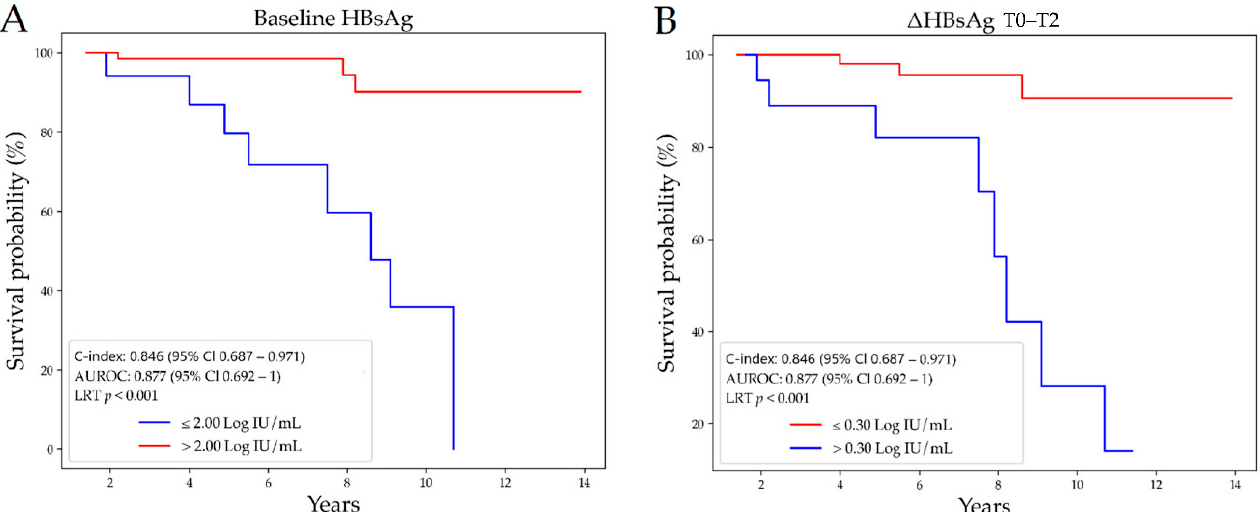
Figure 3. Survival curves for the prediction of HBsAg loss according to baseline HBsAg ≤ 2.00 Log IU/mL ( A ) and Δ HBsAg T0–T2 > 0.30 Log IU/mL ( B ). Survival curve analysis was performed according to the Kaplan–Meier method; the difference between the curves was assessed by a Log rank test. Abbreviations– area under the receiver operating characteristic curve (AUROC), HBsAg decline ( Δ HBsAg), hepatitis B surface antigen (HBsAg), log-rank test (LRT), timepoint (T).